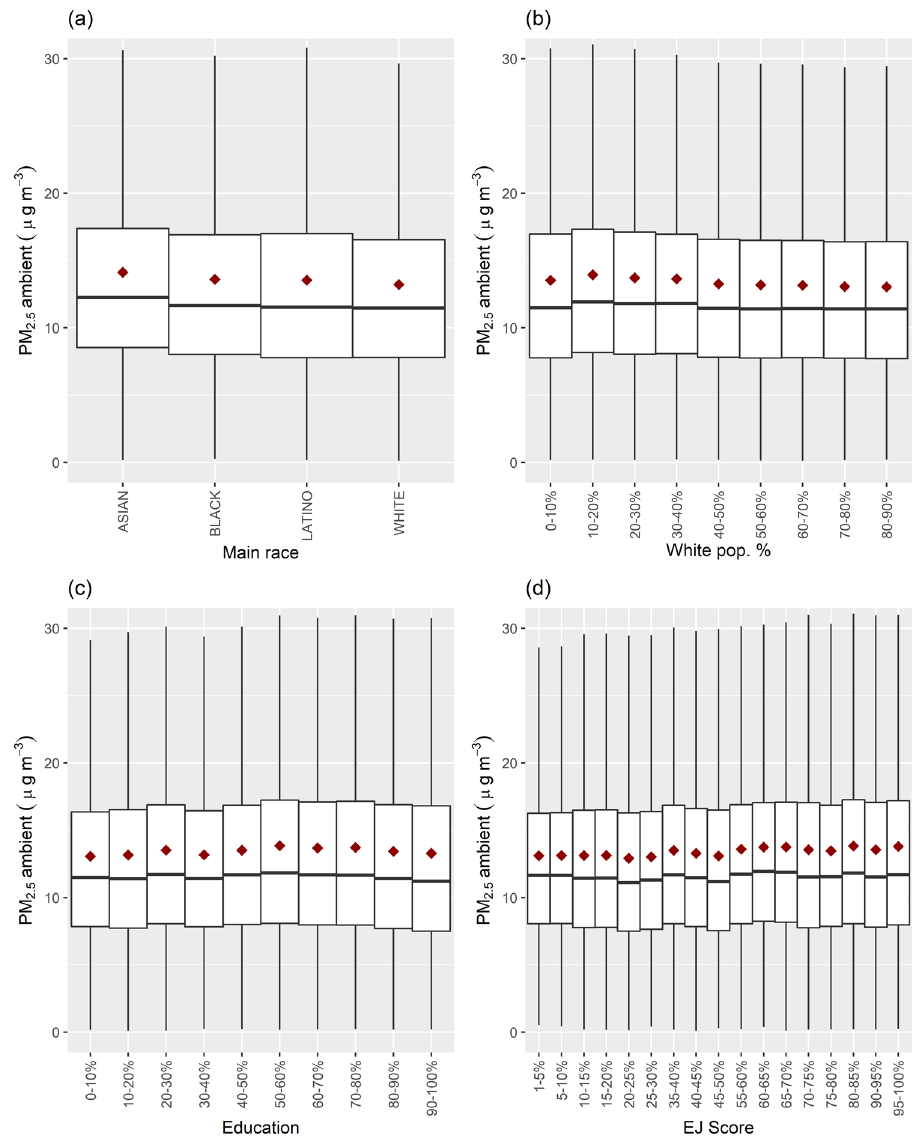
Fig. 5 PM 2.5 concentrations grouped by CalEnviroScreen EJ parameters for the Reference Case. The EJ parameters include ( a ) race, ( b ) white population percentage, ( c ) percent of population with a degree lower than high school, and ( d ) the fi nal score in CalEnviroScreen. Diamonds represent mean concentrations, and the horizontal lines represent the median. Boxes are bound by 25% and 75% ranges. The whiskers extend to 1.5 times of the IQR from the